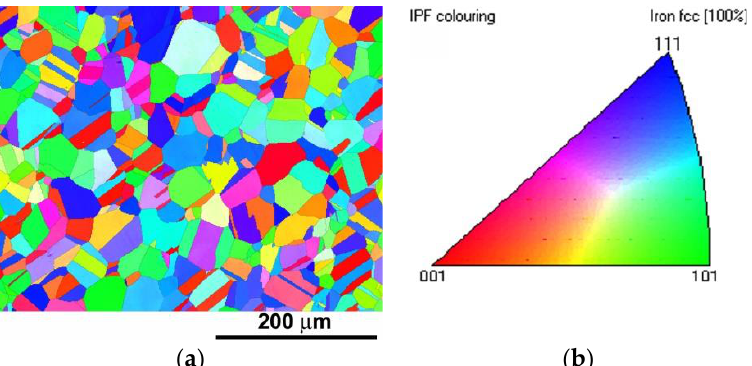
Figure 3. EBSD microstructural analysis of as-received 316H material showing: ( a ) Z-direction inverse pole figure and ( b ) corresponding IPF color key.